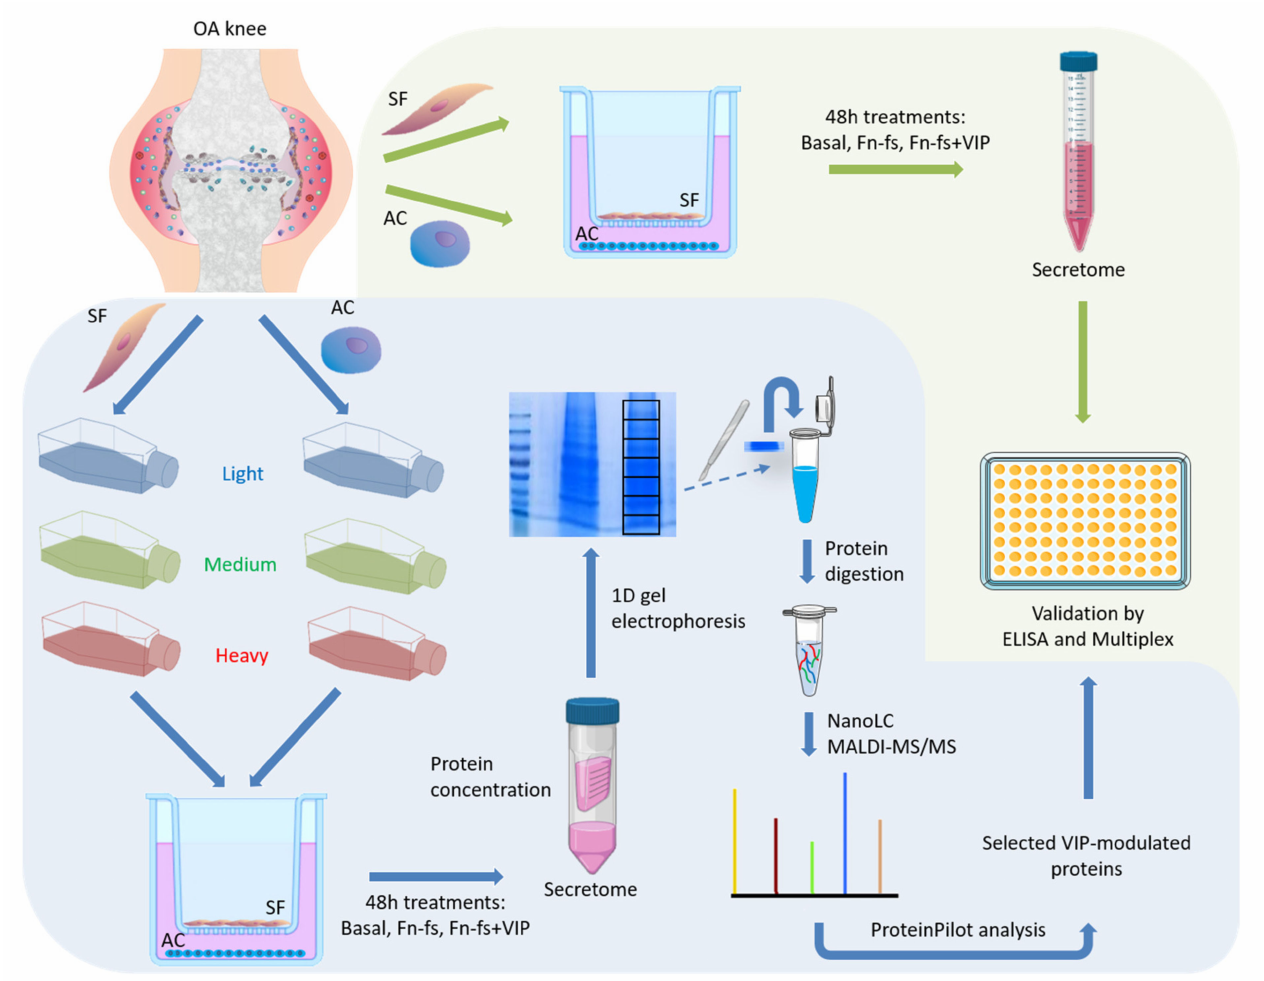
Figure 9. Schematic representation of the experimental